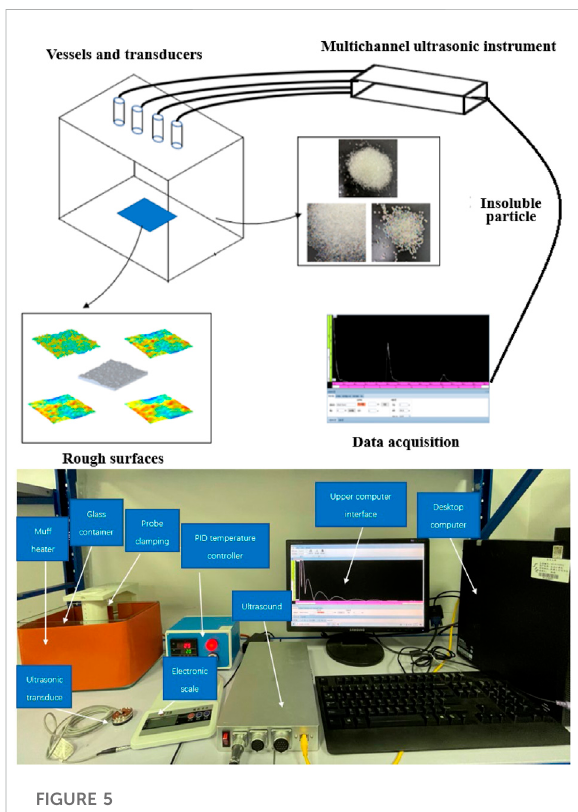
FIGURE 5 Overall experimental platform and schematic diagram.